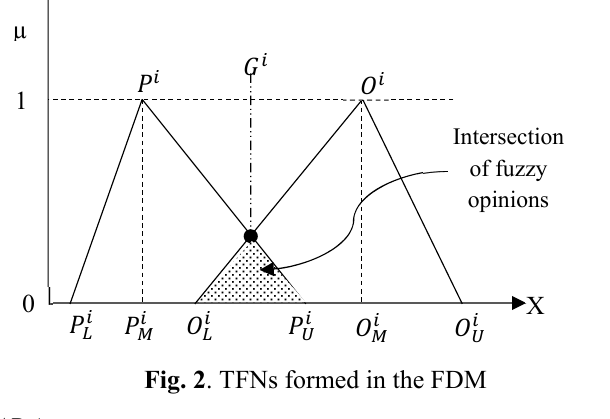
Fig. 2 . TFNs formed in the